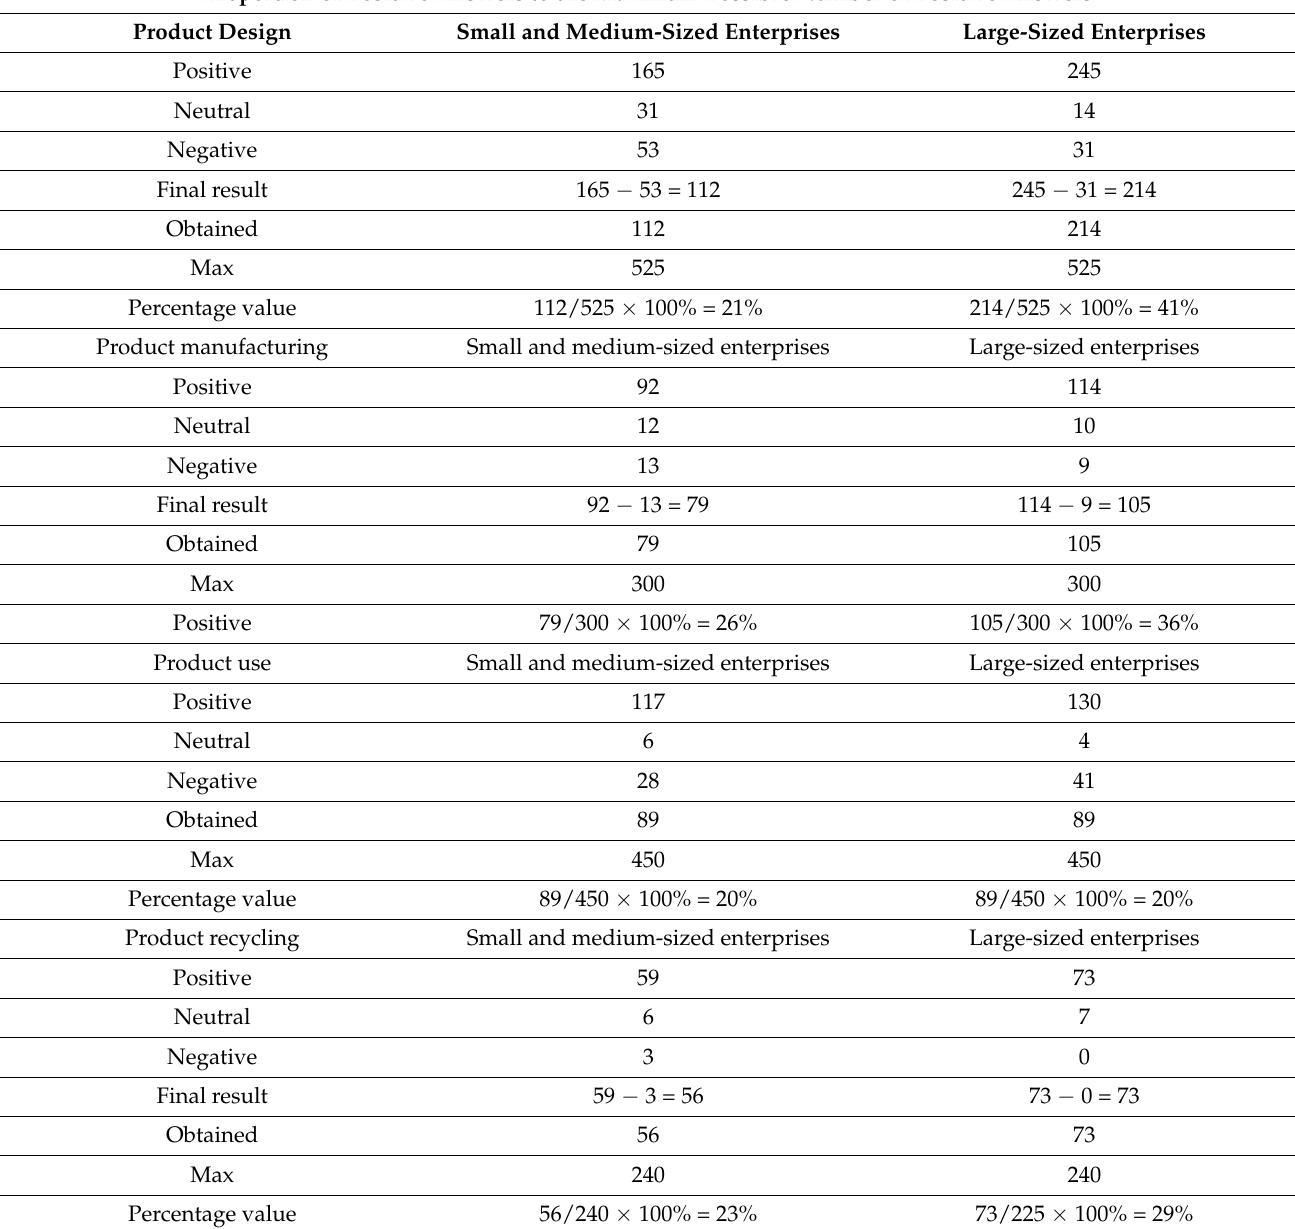
Table 2. The proportion of positive answers to the maximum possible number of positive